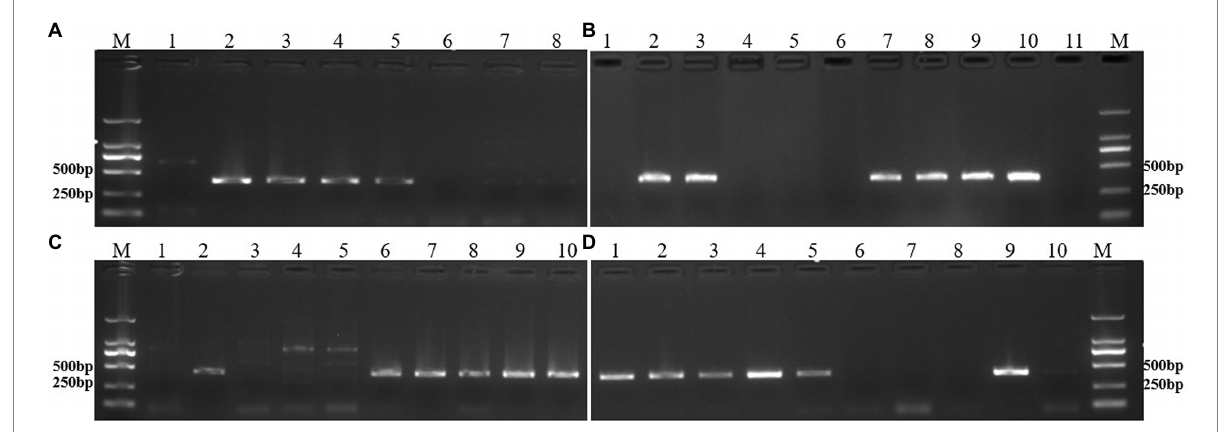
FIGURE 4 PCR results of specific molecular markers. (A) PCR results of the primer pair KU88. Lane 1: CN25, Lane 2: 46-13-3 (6RS), Lane 3: 46-13-11 (6RS), Lane 4: 46-13-16 (6RS), Lane 5: rye QL2, Lane 6: 48-9-2 (6RL), Lane 7: 48-9-5 (6RL), Lane 8: 48-9-6 (6RL). (B) PCR results of the primer pair KU291. Lane 1: CN25, Lane 2: 48-9-8 (6R), Lane 3: 48-9-10 (6R), Lane 4: 48-9-2 (6RL), Lane 5: 48-9-5 (6RL), Lane 6: 48-9-6 (6RL), Lane 7: 46-13- 3 (6RS), Lane 8: 46-13-11 (6RS), Lane 9: 46-13-16 (6RS), Lane 10: rye QL2, Lane 11: CN25. (C) PCR results of the primer pair KU86. Lane 1: CN25, Lane 2: rye QL2, Lane 3: 46-13-3 (6RS), Lane 4: 46-13-11 (6RS), Lane 5: 46-13-16 (6RS), Lane 6: 48-9-2 (6RL), Lane 7: 48-9-5 (6RL), Lane 8: 48-9- 6 (6RL), Lane 9: 48-9-8 (6R), Lane 10: 48-9-10 (6R). (D) PCR results of the primer pair KU153. Lane 1: 48-9-2 (6RL), Lane 2: 48-9-5 (6RL), Lane 3: 48-9-6 (6RL), Lane 4: 48-9-8 (6R), Lane 5: 48-9-10 (6R), Lane 6: 46-13-3 (6RS), Lane 7: 46-13-11 (6RS), Lane 8: 46-13-16 (6RS), Lane 9: rye QL2, Lane 10: CN25. Lane M: DNA marker DL2000. 6RS: 6RS ditelosomic addition lines; 6RL: 6RL ditelosomic addition lines; 6R: 6R disomic addition